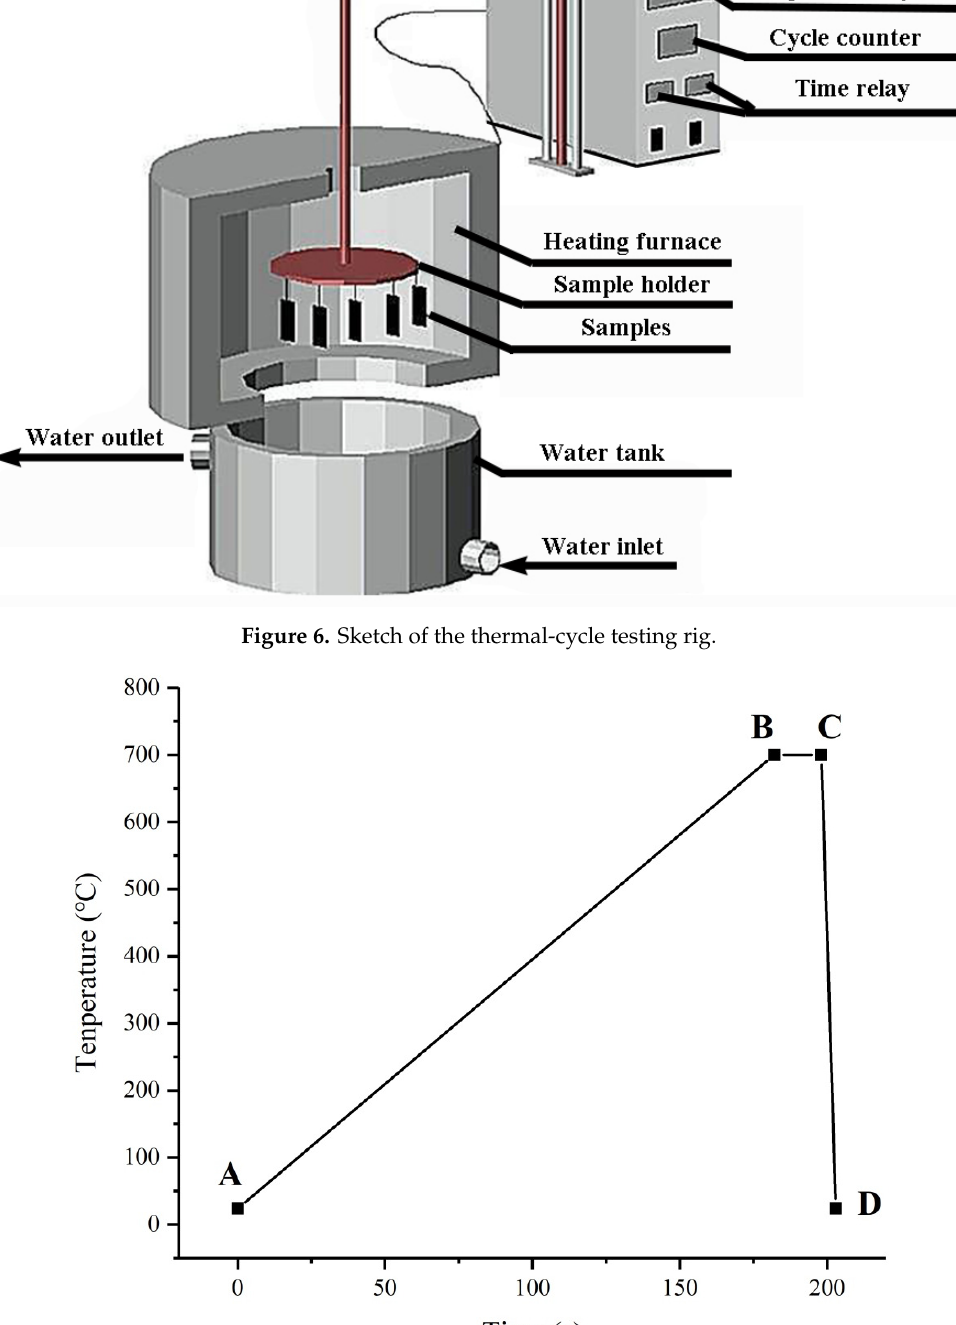
Figure 7. The actual temperature profile of one thermal cycle (Point A and D—25 °C; B and C—700 °C).